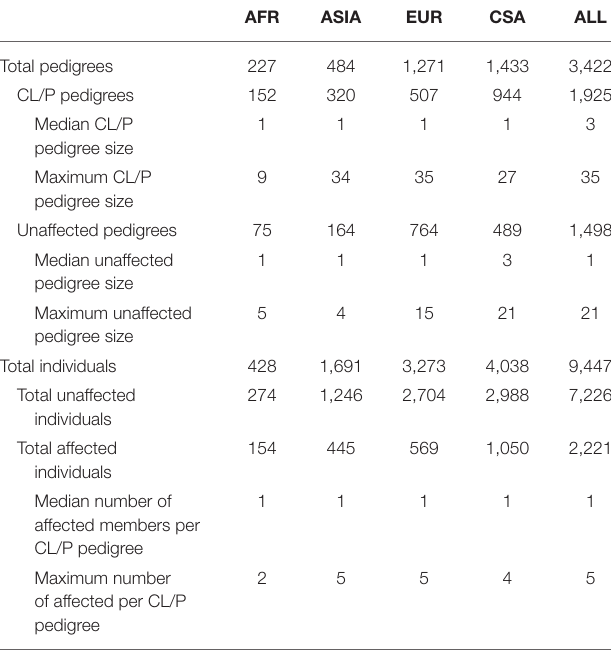
TABLE 1 | Study sample